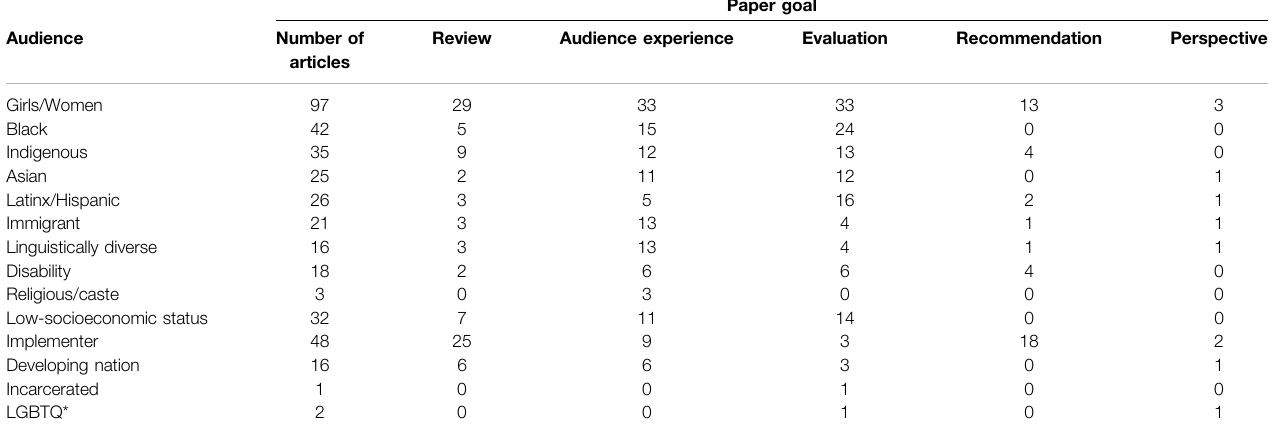
TABLE 2 | Comparison of audience and paper